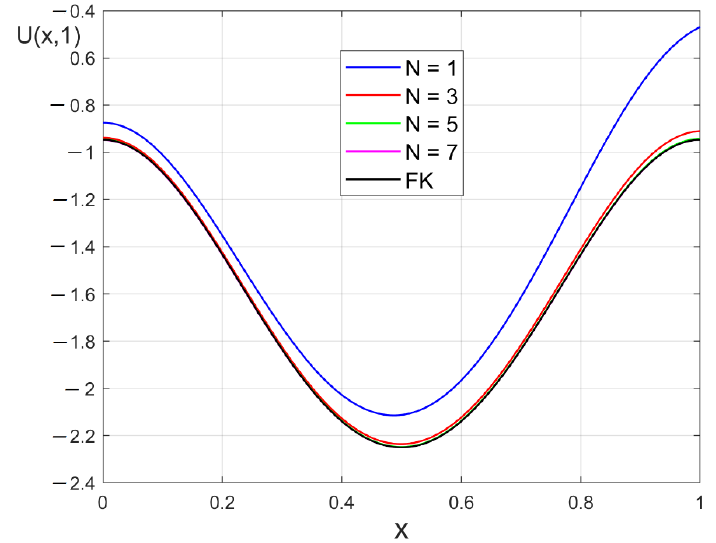
Figure 7. A plot for the potential 𝑈(𝑥′,𝑧′) versus 𝑥′ at 𝑧′ = 1 , 𝜎′ = 1, and 𝜀 = 1 for different numbers of atoms in the chain 𝑁 . FK is the Frenkel – Kontorova